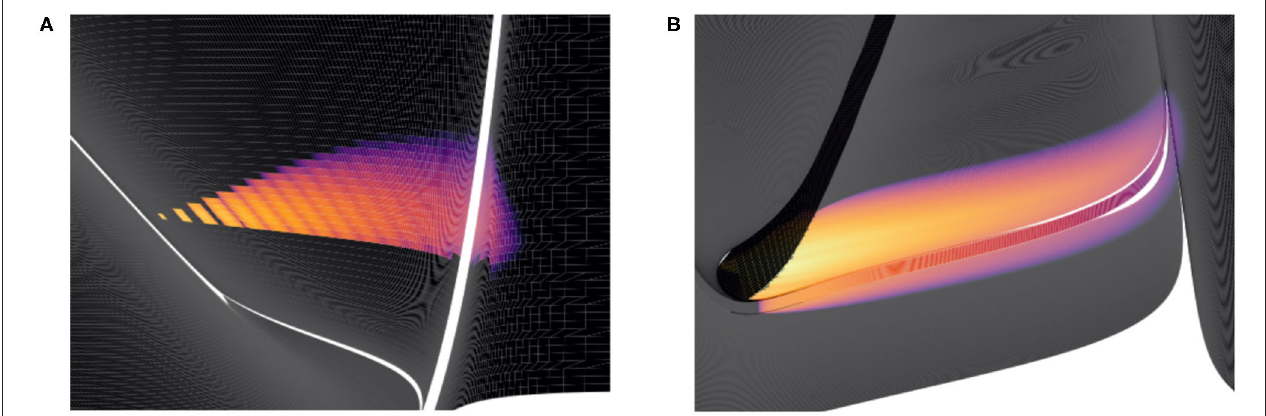
FIGURE 9 | Heat plots for the probability density functions of two populations in MIIND. Brightness (more yellow) indicates a higher probability mass. Scales have been omitted as the underlying neuron models are arbitrary. (A) When the Poisson master equation is solved, probability mass is pushed to the right (higher membrane potential) in discrete steps. As time passes, the discrete steps are smoothed out due to the movement of mass according to the deterministic dynamics (following the strip). (B) A combination of mass travelling along strips and being spread across the state space by noisy input produces the behaviour of the population.